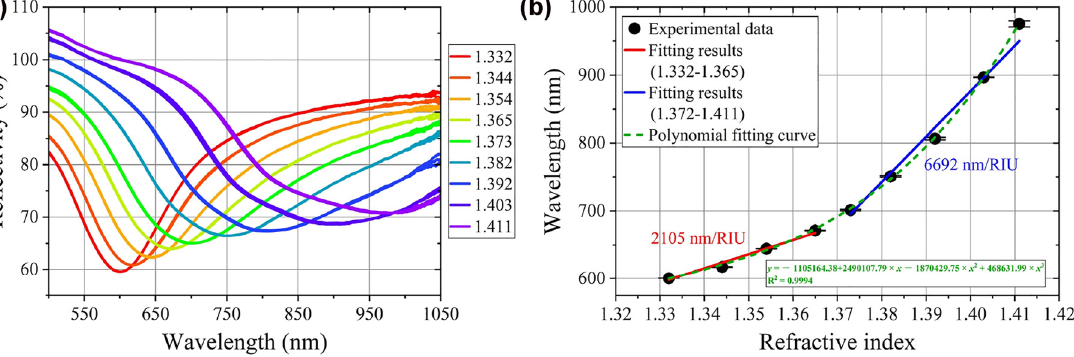
Figure 9: RI response of the as-fabricated sensing probe: (a) SPR spectrum response to different RIs; (b) relationship between resonance wavelength and